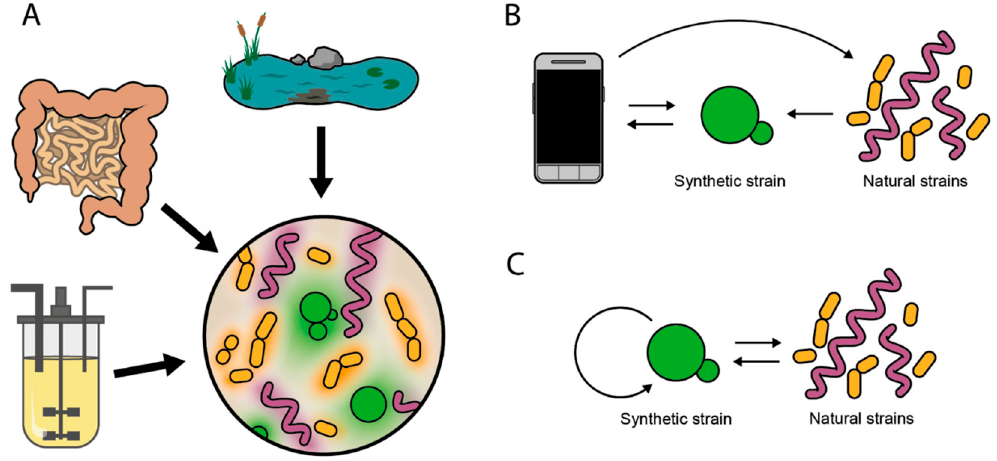
Figure 3. Ecosystem intervention. ( A ) Various ecosystems such as a natural water source, the human gut, or a bioreactor are susceptible to interventions using engineered cell populations to enable, e.g., remediation, therapy, or optimization processes, respectively. The engineered cells (green) coexist and interact with the natural microbiota (purple and yellow) via secreted molecules (corresponding colored halos around cells). ( B ) External control. Synthetic cells (center) can detect and report specific properties of the natural population (right). Data collection and computer-aided analysis (left) can be used to modify the detector itself (e.g., replenish the detector strain to avoid its extinction) or the natural population (e.g., add a specific dose of a species-specific toxin). ( C ) Internal control. The synthetic cell interacts bidirectionally with the natural microbiota. Using the information collected, the synthetic cell can both control itself (e.g., maintain its relative abundance) and the natural system (e.g., secrete killing agents).